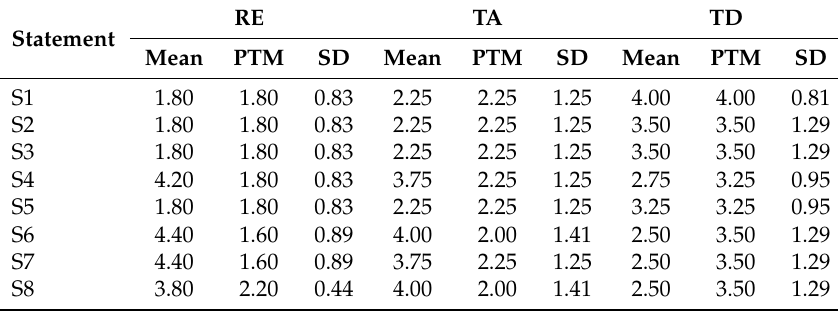
Table 6. Mean, post-transformation mean (PTM), and standard deviation (SD) of Cross-Platform Usability Scale (CPUS) responses.